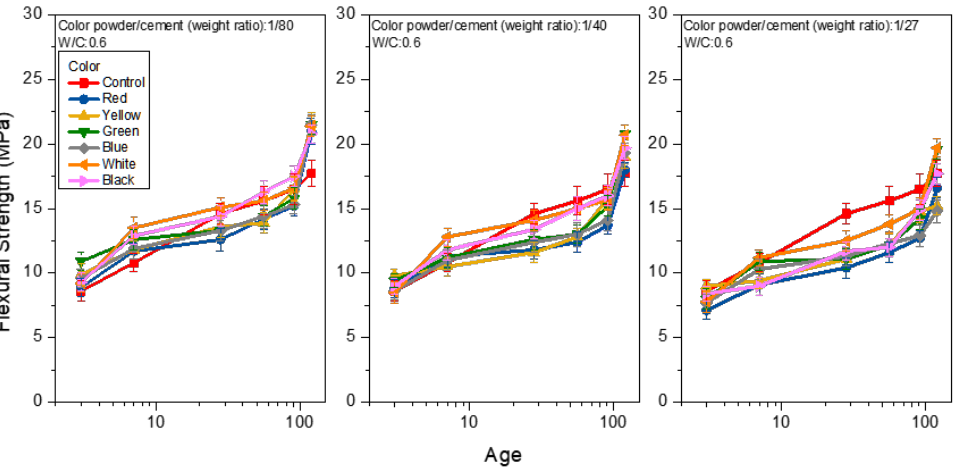
Figure 9. Flexural strength of colored mortar at W/C = 0.5 and under saturated limewater curing when weight ratios of color powder/cement at 1:80, 1:40, and 1:27 are added.